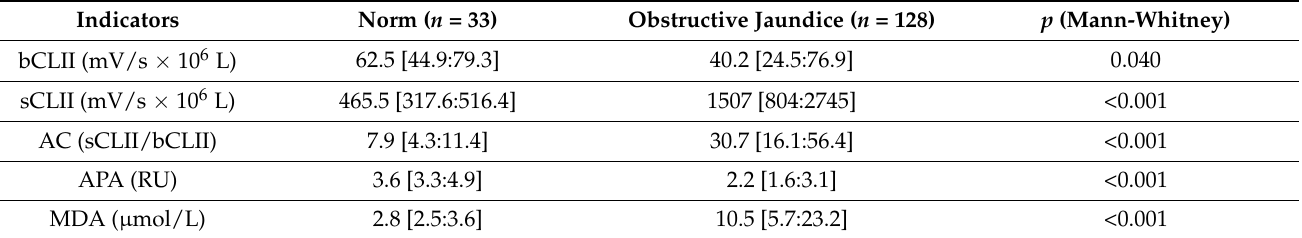
Table 2. Indicators of free radical processes in patients with obstructive jaundice during hospitalization. Indicators Norm ( n = 33) Obstructive Jaundice ( n = 128) p (Mann-Whitney) bCLII (mV/s × 10 6 L) 62.5